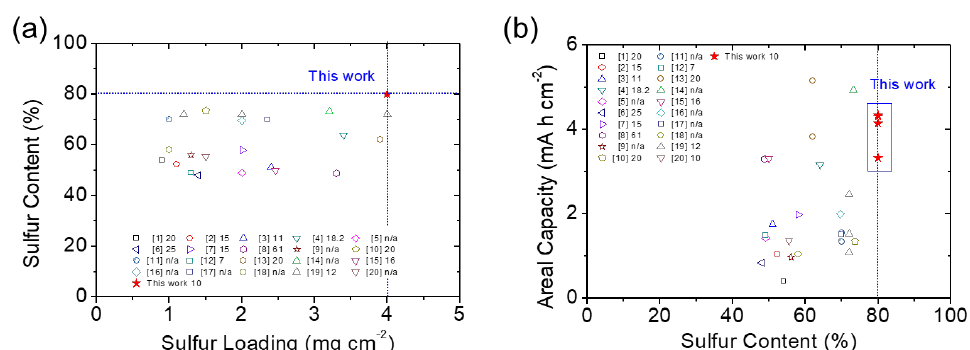
Figure 4. Comparative analysis of the battery performances and electrochemical characteristics of the C – S composite cath- ode with reported Li – S research using different C – S composites: ( a ) sulfur loading, sulfur content, and electrolyte-to-sulfur ratio (the electrolyte-to-sulfur ratio with a unit as µL mg −1 is provided after the number of citations; see supporting infor- mation); ( b ) sulfur content, areal capacity, and electrolyte-to-sulfur